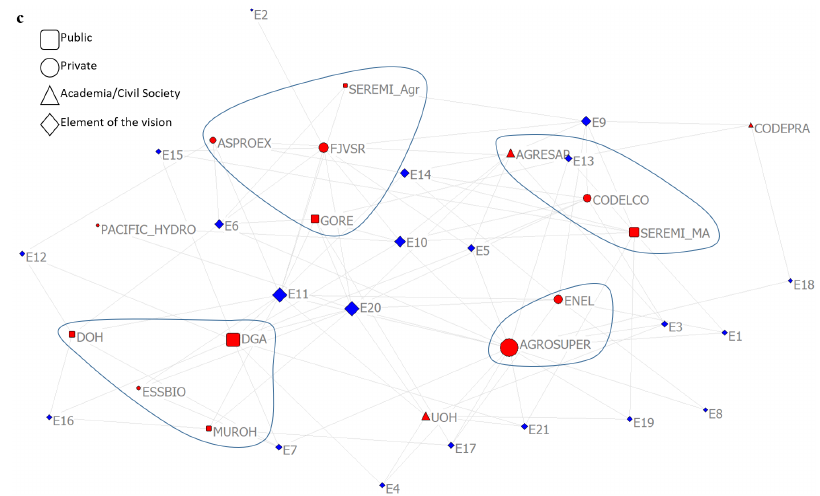
Figure 8. Network of stakeholders’ influence in achieving elements of the shared vision (Figure 6) developed for the RRB: ( a ) all levels of influence; ( b ) low level of influence; and ( c ) high level of